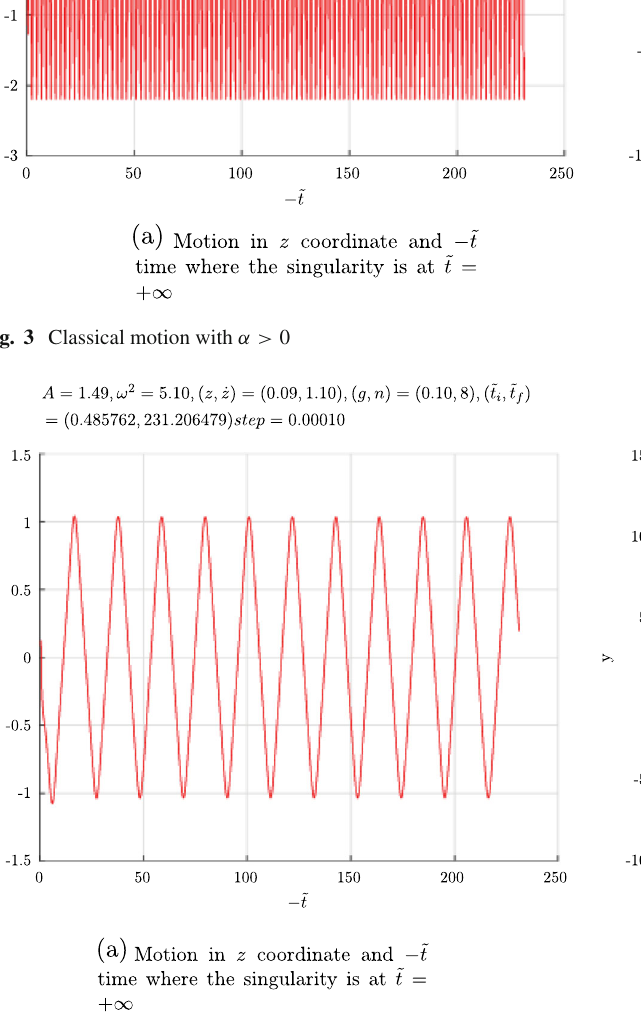
Fig. 4 Another classical motion with α > 0 with a smoother